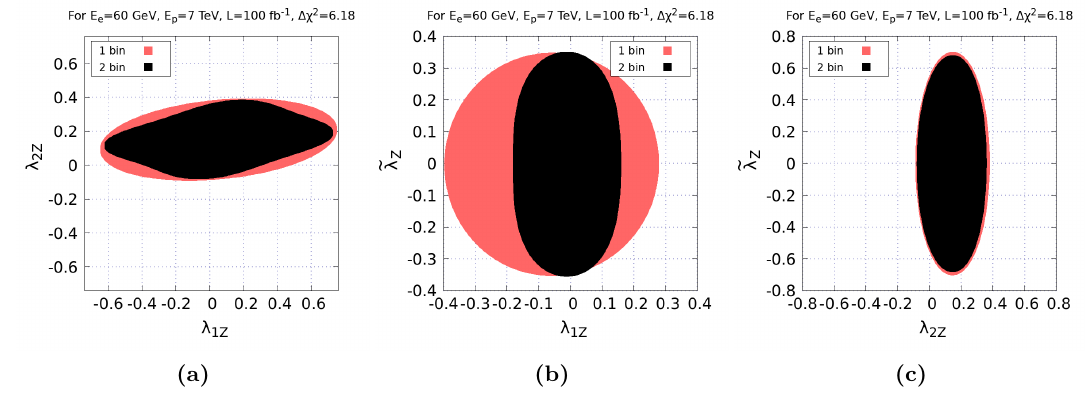
Figure 9 . Two-dimensional parameter space for HZZ BSM parameters at L = 100 fb − 1 using cross section (red) and ∆ φ distribution (black) as